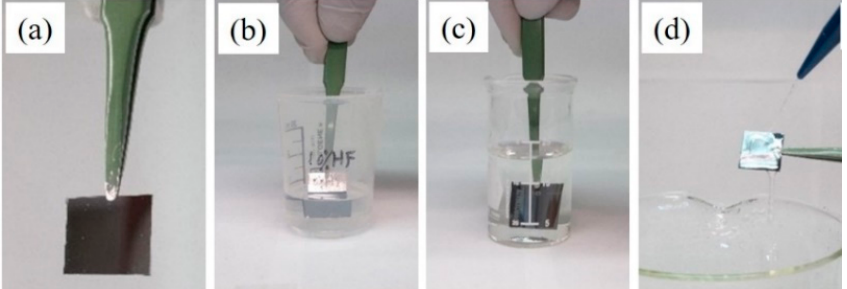
Figure 1. Experimental steps in the synthesis process: ( a ) cleaved and cleaned Si substrate; ( b ) immersion in 10% HF for 2 min, to dissolve the surface oxide; ( c ) immersion in 0.3 mM metal precursor solution for 5 min; ( d ) rinse sample with deionized water.